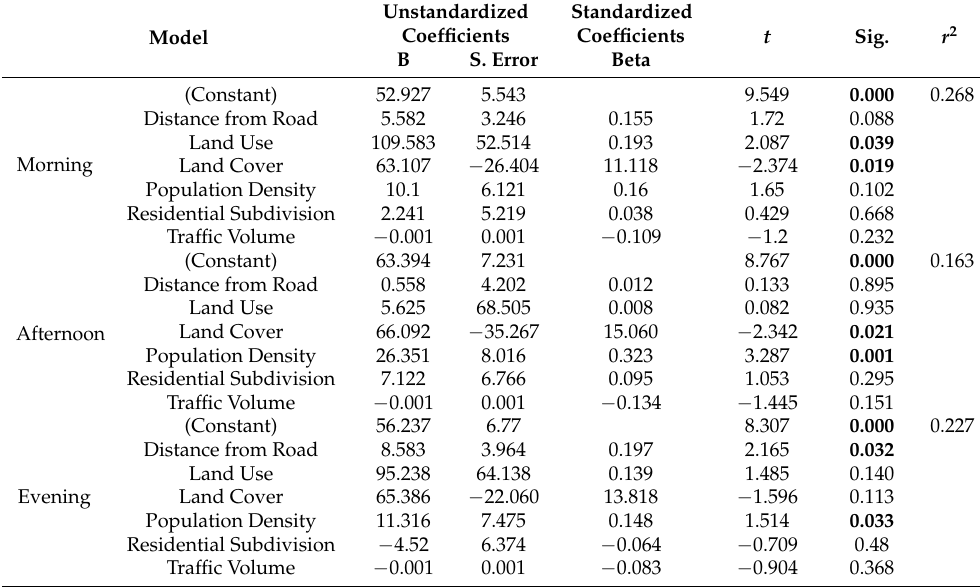
Table 4. Factor Determining the Noise Level.